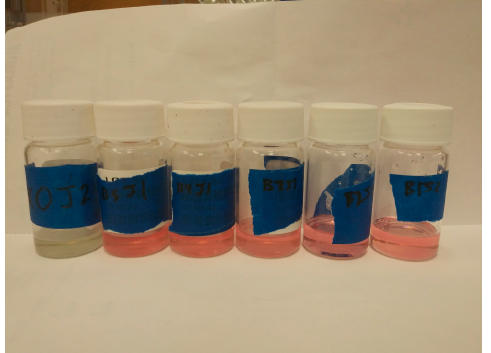
Figure A3. Photograph of 90% w/w HAN + water samples no additive, 0.05%, 0.1%, 0.5%, 1%, and 5% Bipy respectively, from left to right.